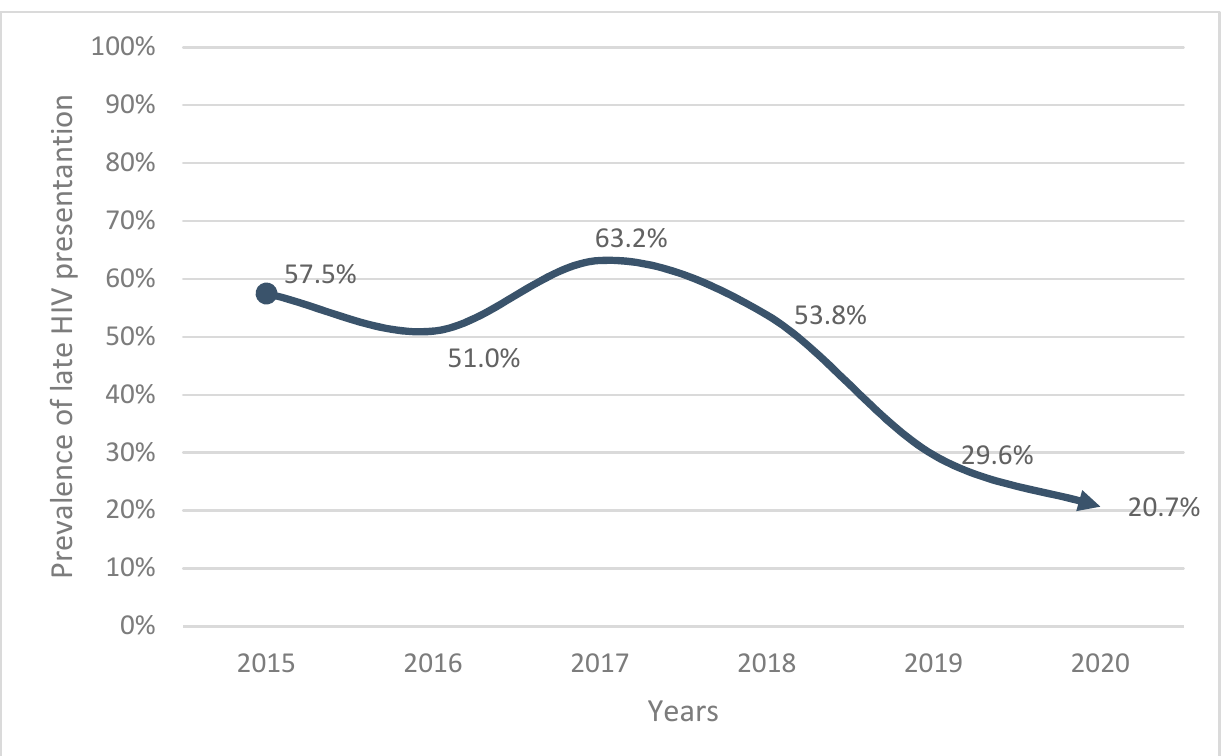
Table 3. Multivariate results (AOR and OR) for variables associated with late HIV diagnosis at the Ndlavela Health Center, Mozambique. Explanatory Variables